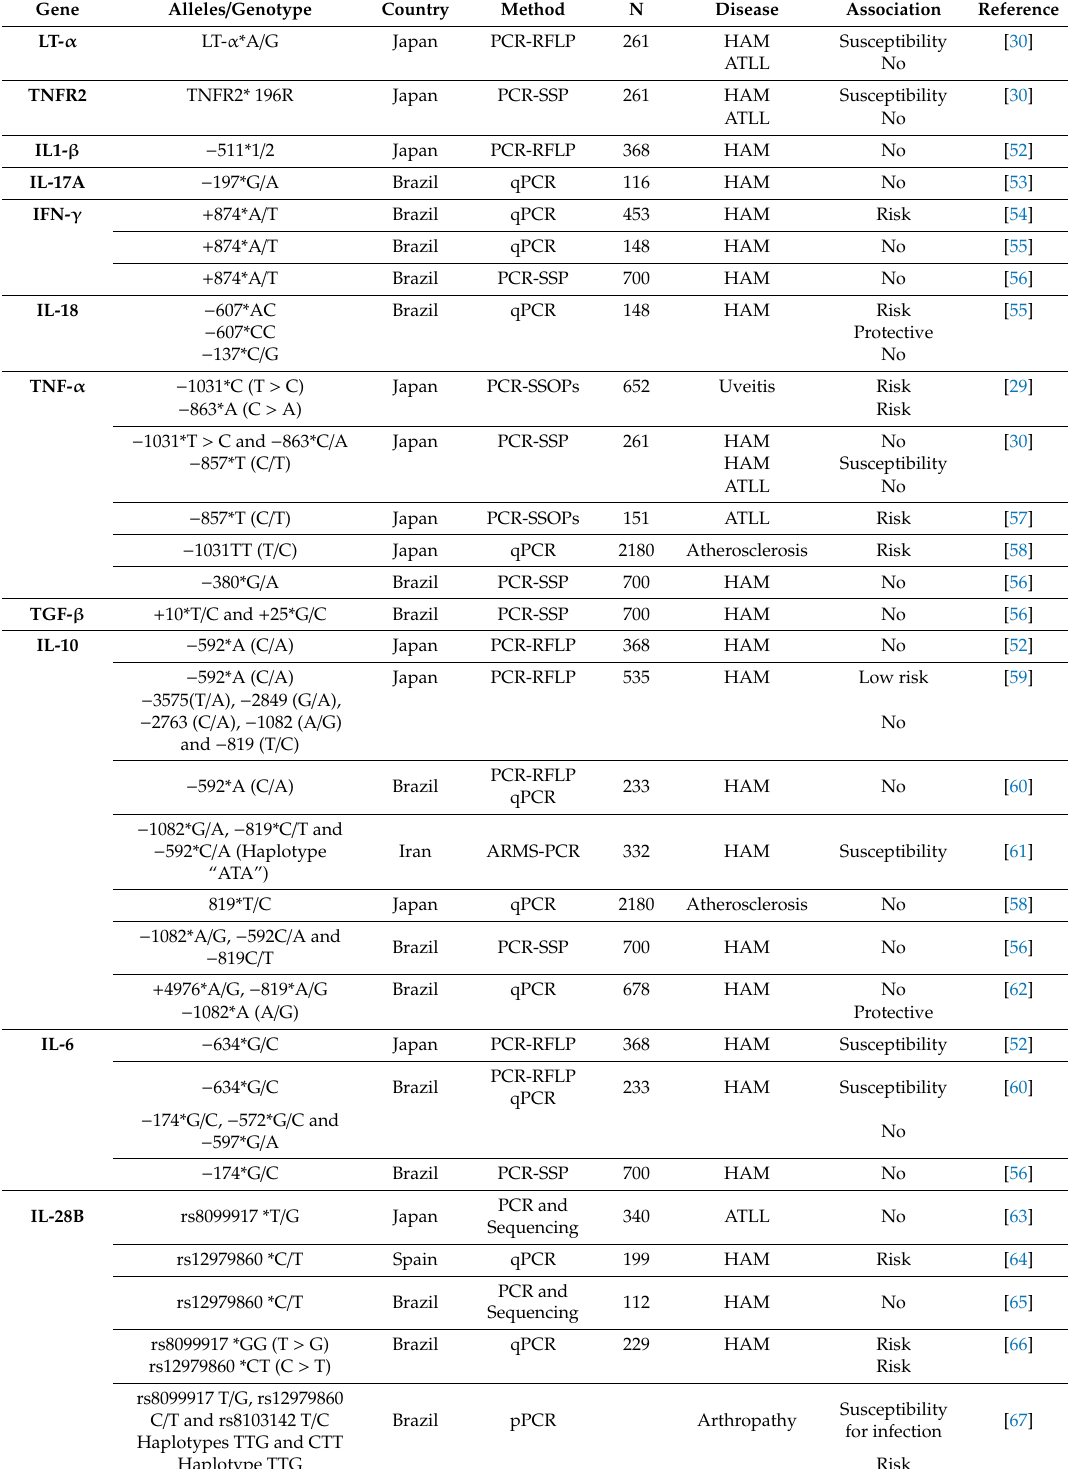
Table 2. Main polymorphisms in cytokine, NF-kB1, CYP1A1, MBL, and apoptotic genes associated with HTLV-1